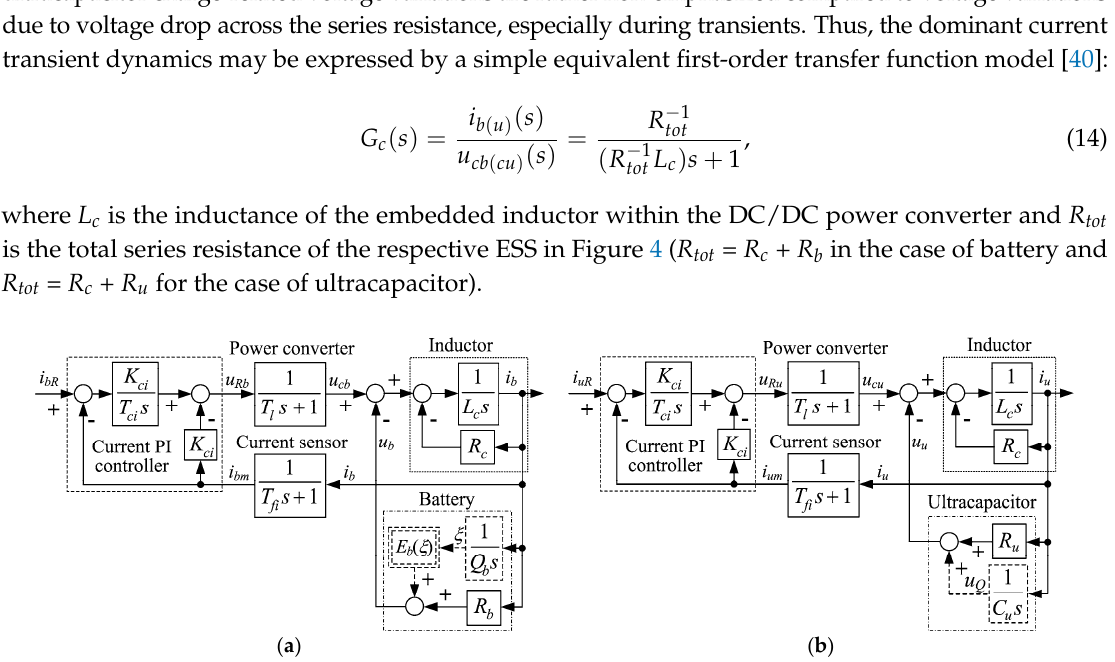
Figure 4. Current control loops for battery ESS ( a ) and ultracapacitor ESS ( b ), featuring feedback PI controller, simplified power converter model with embedded inductor and simplified ESS models.